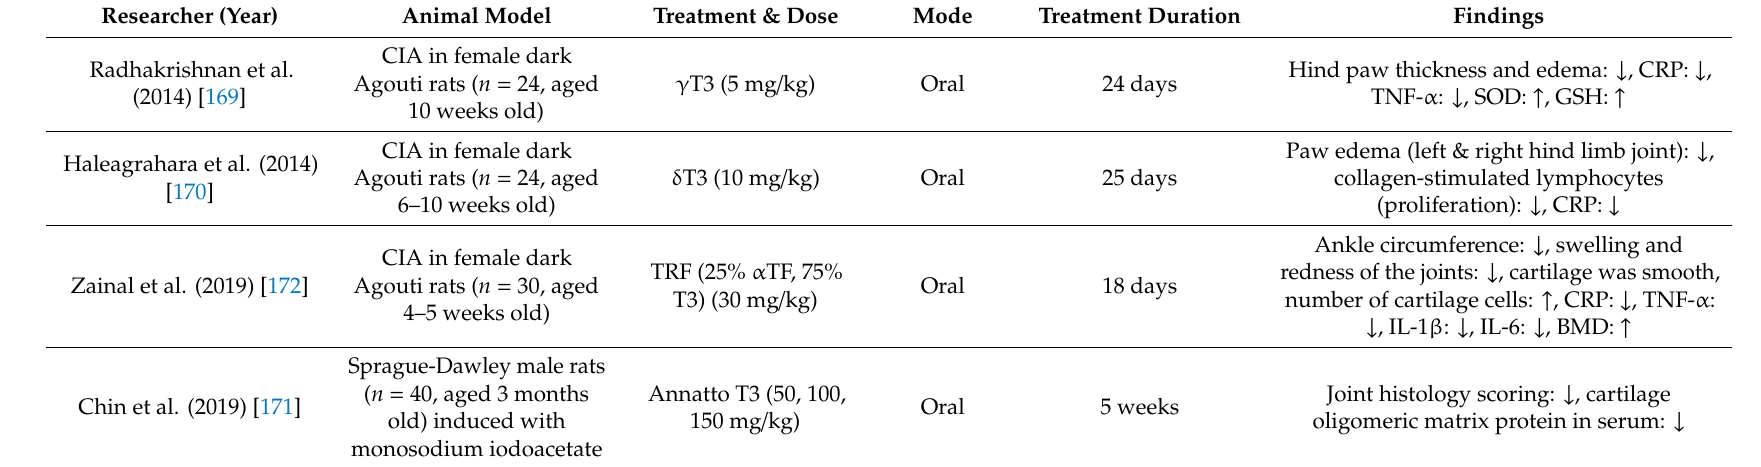
Table 10. E ff ects of T3 on arthritis in